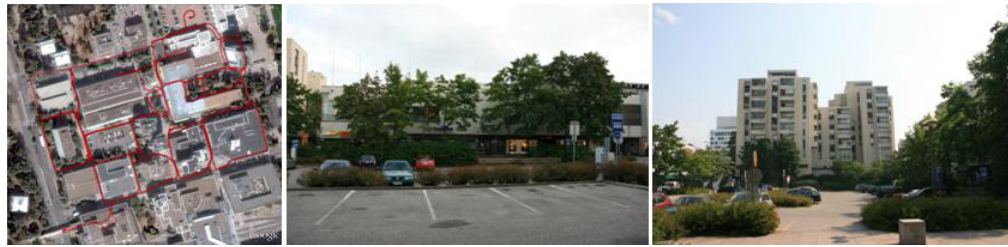
Figure 2. The ROAMER trajectory and images from the Tapiola area (photo on the Left from Kaartinen, H., 2010).